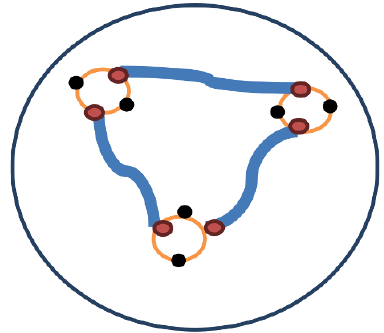
Figure 1 . 3-point amplitude on sphere where orange circles are closed string vertex operators, blue strips are thickened propagators near the AdS boundary, white regions are D3-brane holes near the AdS horizon, black dots are picture-raising operators, and red dots are “beads” E on the closed